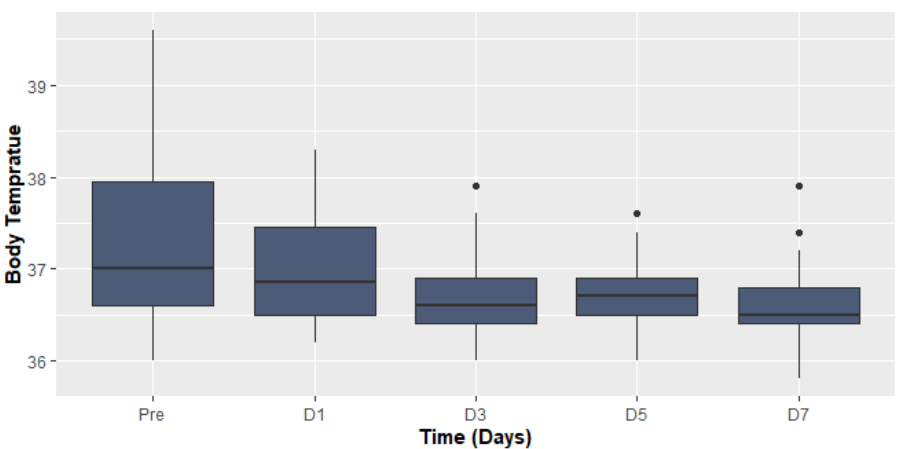
Figure 1. Body temperature before and after Tocilizumab.